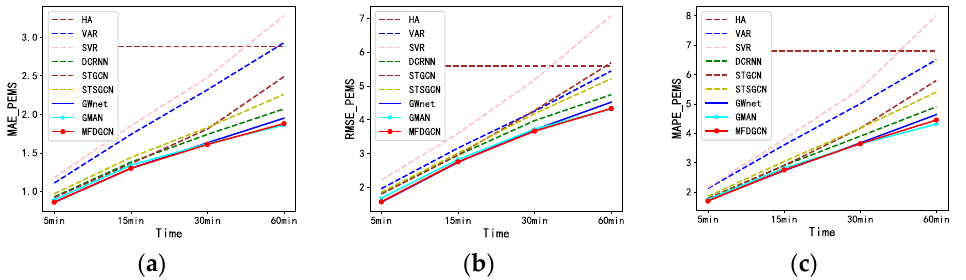
Figure 8. Comparison of prediction performance at each time step on the PeMS_BAY data set. ( a ) MAE values comparison; ( b ) RMSE values comparison; ( c ) MAPE values comparison.